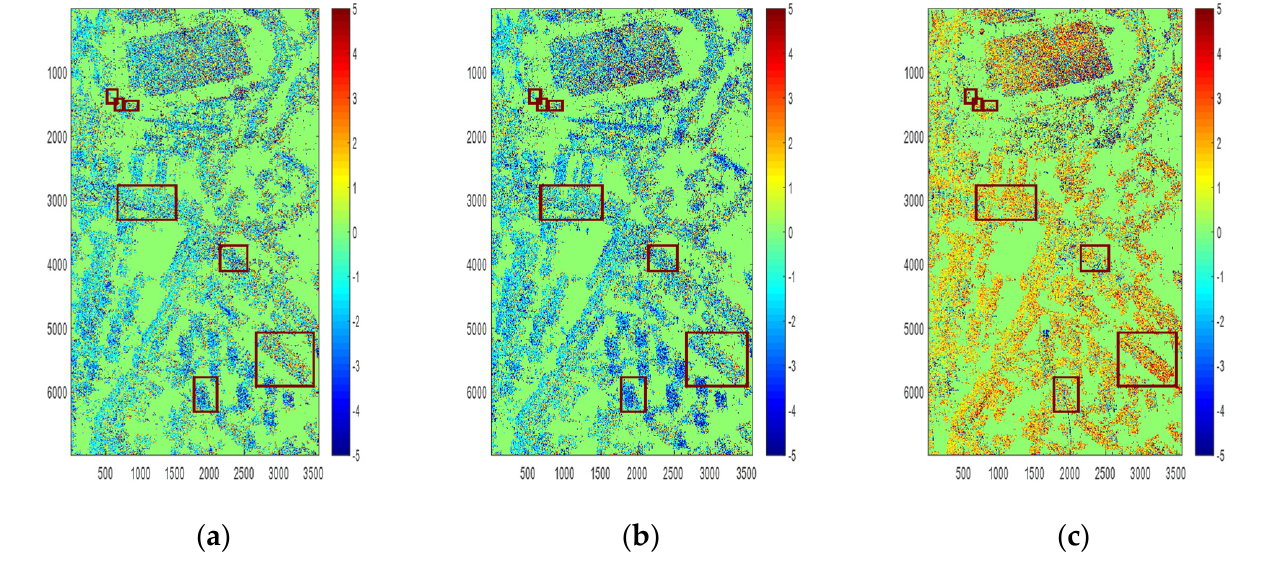
Figure 11. Height difference of different polarization modes in Fudan. ( a ) Height difference of PolInSAR and single scattering. ( b ) Height difference of PolInSAR and double scattering of 0 degrees. ( c ) Height difference of PolInSAR and double scattering of 45 degrees.